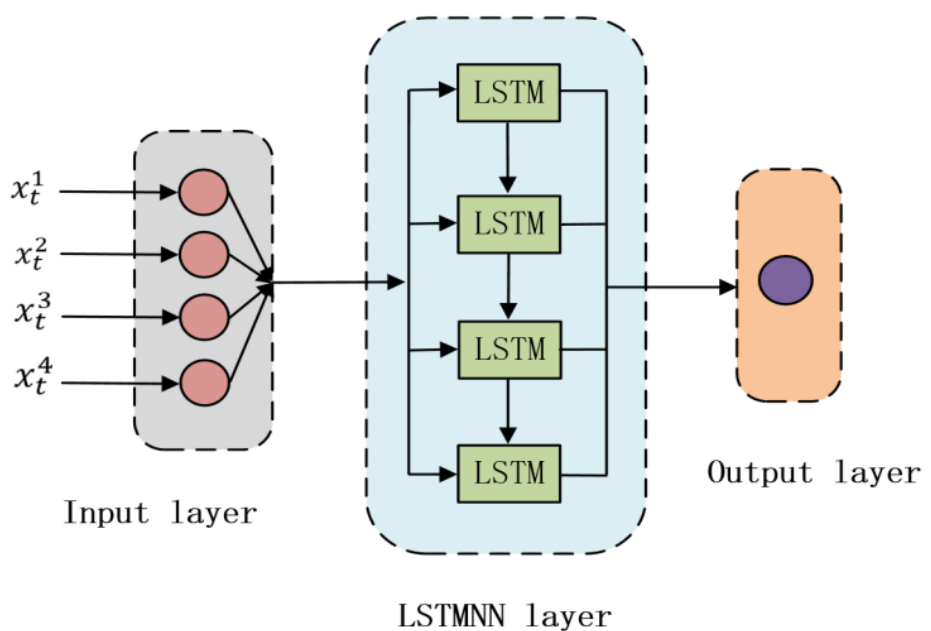
Figure 14. Model network structure diagram.